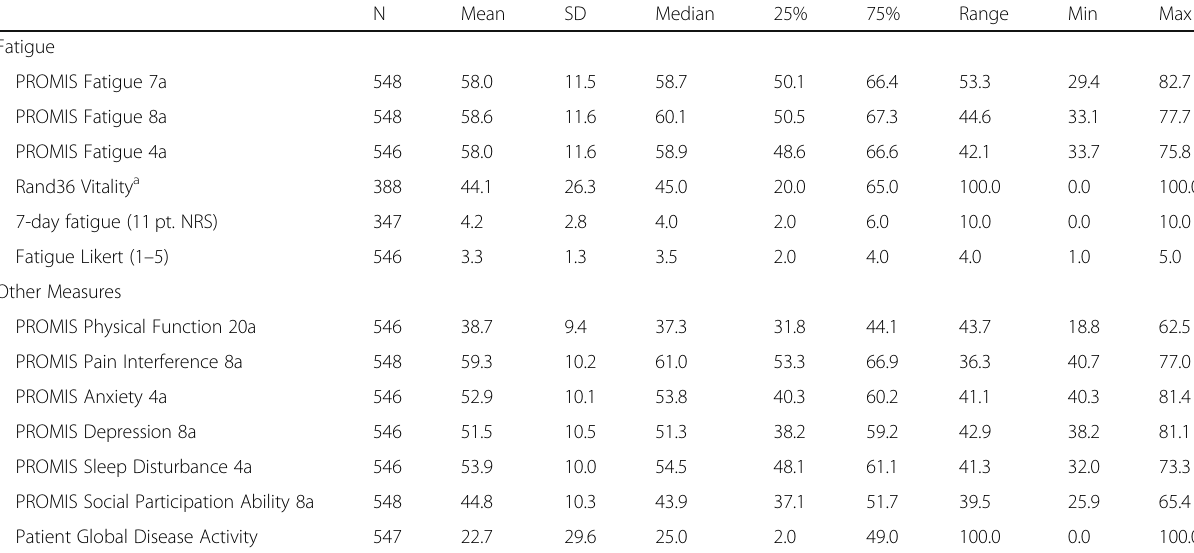
Table 2 Scores on PROMIS Fatigue short forms and other patient reported